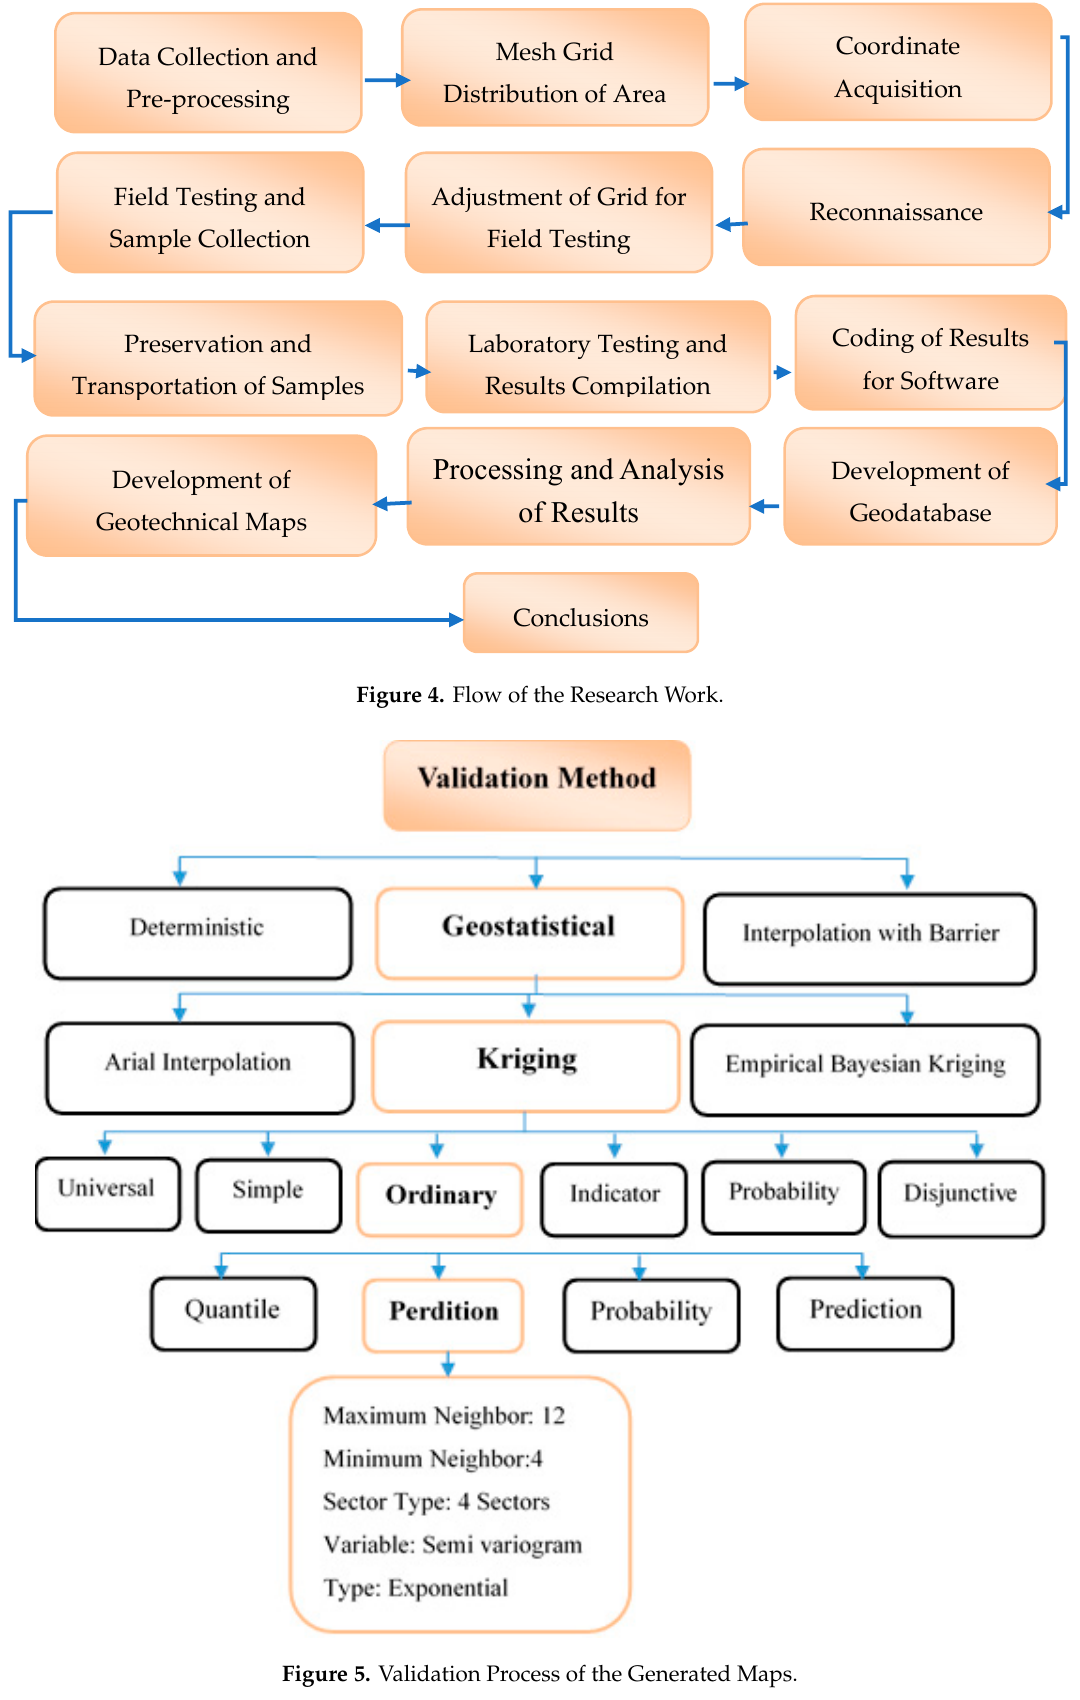
Figure 5. Validation Process of the Generated Maps.